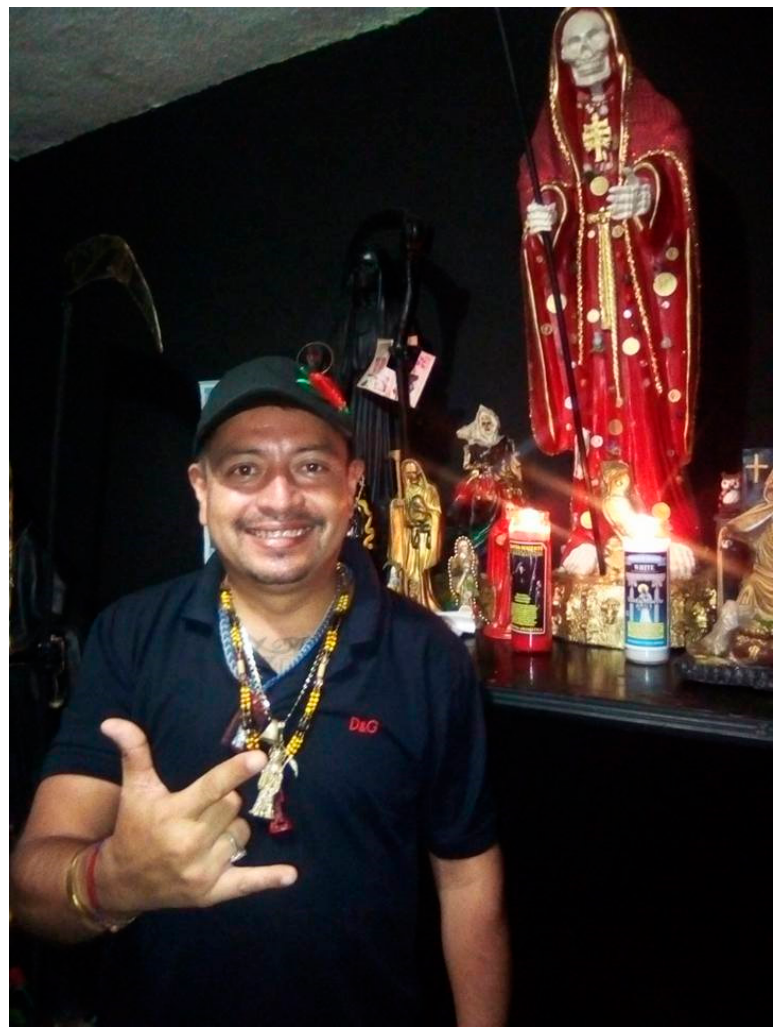
Figure 2. Dr. Muerte standing in front of a Santa Muerte altar wearing the Santeria-influenced Santa Muerte necklace that is said to ward off evil energy.